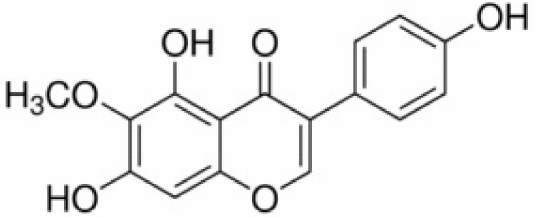
Figure 1. The chemical structure of